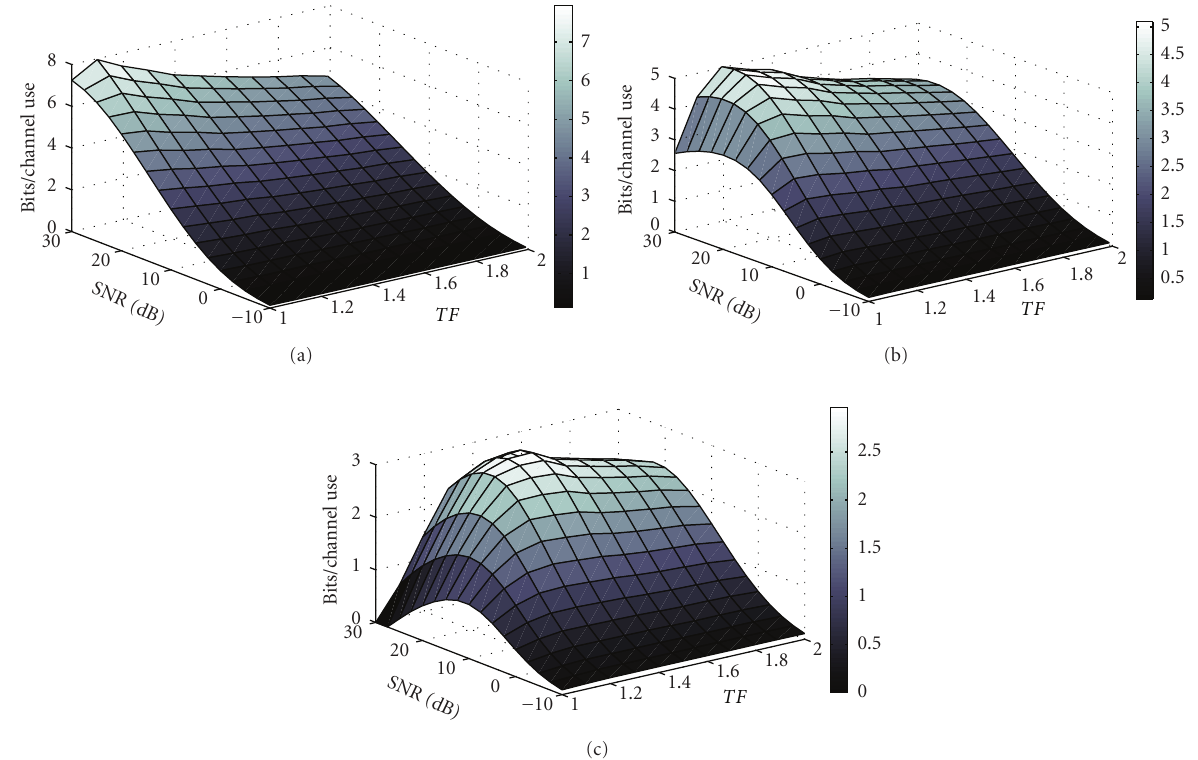
Figure 4: Lower-bound C L 1 as a function of TF and the SNR ρ for the three channels depicted in Table 1.